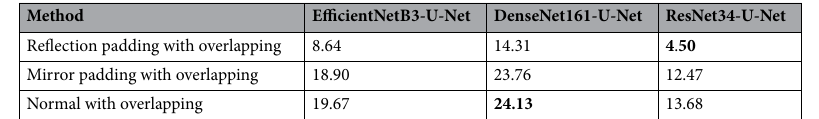
Method Reflection padding with overlapping Mirror padding with overlapping Normal with Table 2. Average runtime per WSI (in seconds) for EfficientNetB3-U-Net, DenseNet161-U-Net, and ResNet34-U-Net. Significant values are in bold.